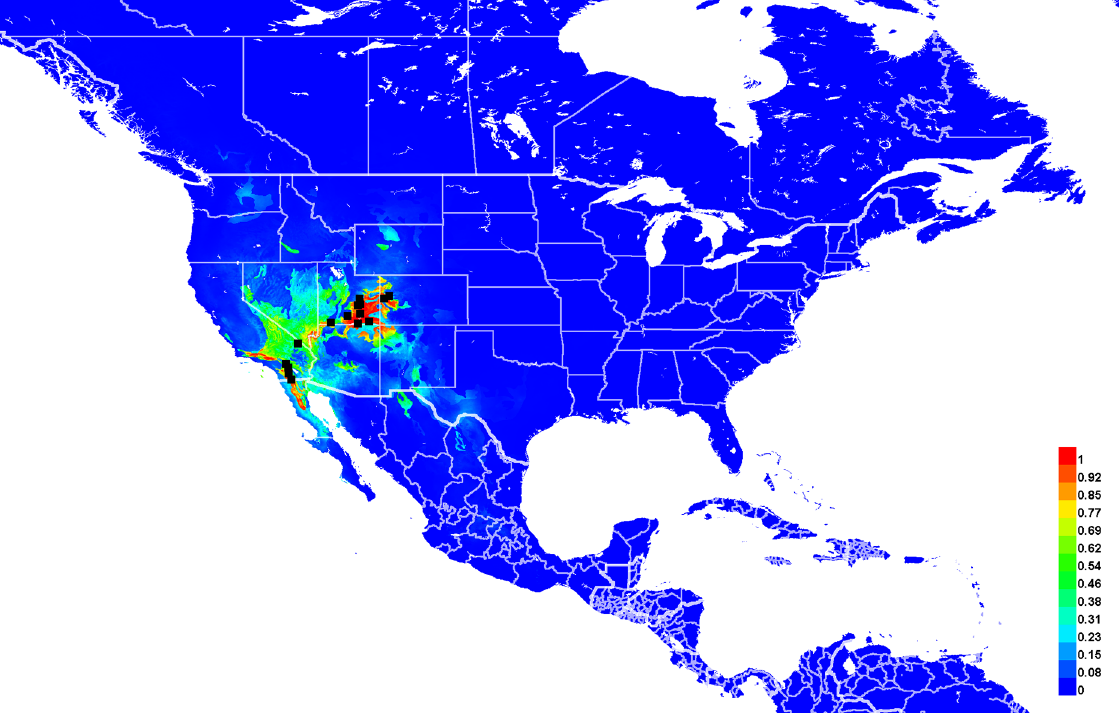
Fig. 40. Georeferenced collection records of Lasioglossum ( D. ) festinum sp. nov. (black squares) and predicted distribution by maximum entropy ecological niche modeling in Maxent (colour shading). Warmer colours indicate higher cloglog probability of